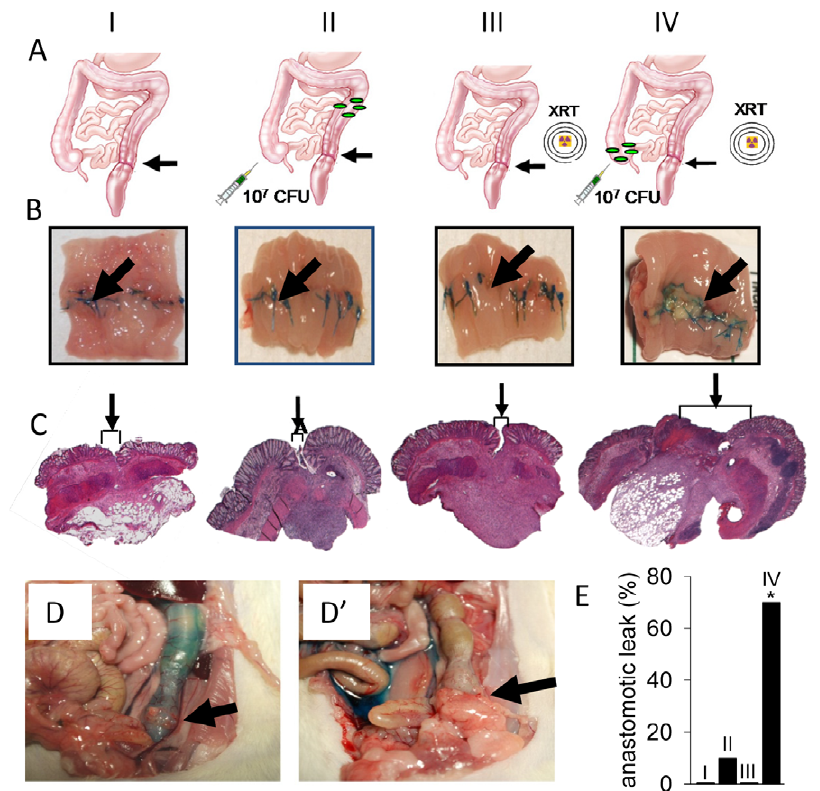
Figure 1. Anastomotic leak in rats exposed to pre-operative radiation and intestinal P.aeruginosa . (A) Sketch of anastomosis model and treatment groups. Treatment groups: I, anastomosis only; II, anastomosis + cecal injection of P. aeruginosa MPAO1, 10 7 CFU; III, radiation + anastomosis; IV, radiation + anastomosis + cecal injection of P. aeruginosa MPAO1 (10 7 CFU). Black arrows indicate the anastomotic site. (B) Excised and exposed suture lines of anastomotic sites. All suture lines are grossly intact except for group IV where ulceration/dehiscence is noted by the black arrow. (C) H&E staining of anastomotic tissues. Arrows and brackets indicate width of tissue apposition at suture line. (D, D’, E) Methylene blue assessment of anastomotic integrity demonstrating rare to no leaks in groups I–III (D) and gross extravasation in group IV (D’). Arrows indicate the site of anastomosis. (E) Incidence of anastomotic leak between groups. n=12 (group I), n=16 (group II), n=9 (group III), n=18 (group IV), *p , 0.01.